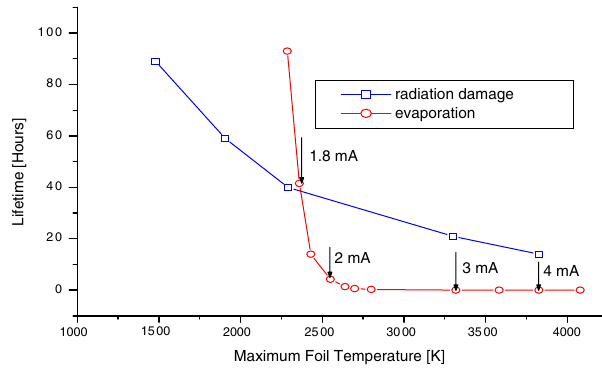
FIG. 4. (Color) Calculated dependences of the lifetime of BNL linac foil due to processes of radiation damage and evaporation.